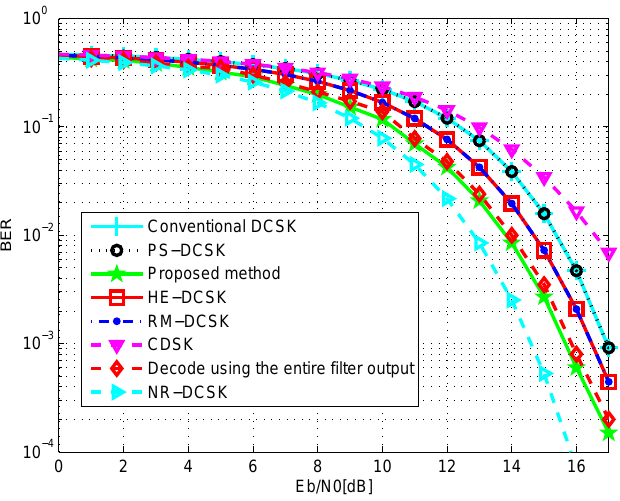
Figure 5. BER versus E b / N 0 for conventional DCSK, NR-DCSK, HE-DCSK, RM-DCSK, PS-DCSK, CDSK and the proposed method over AWGN channel.